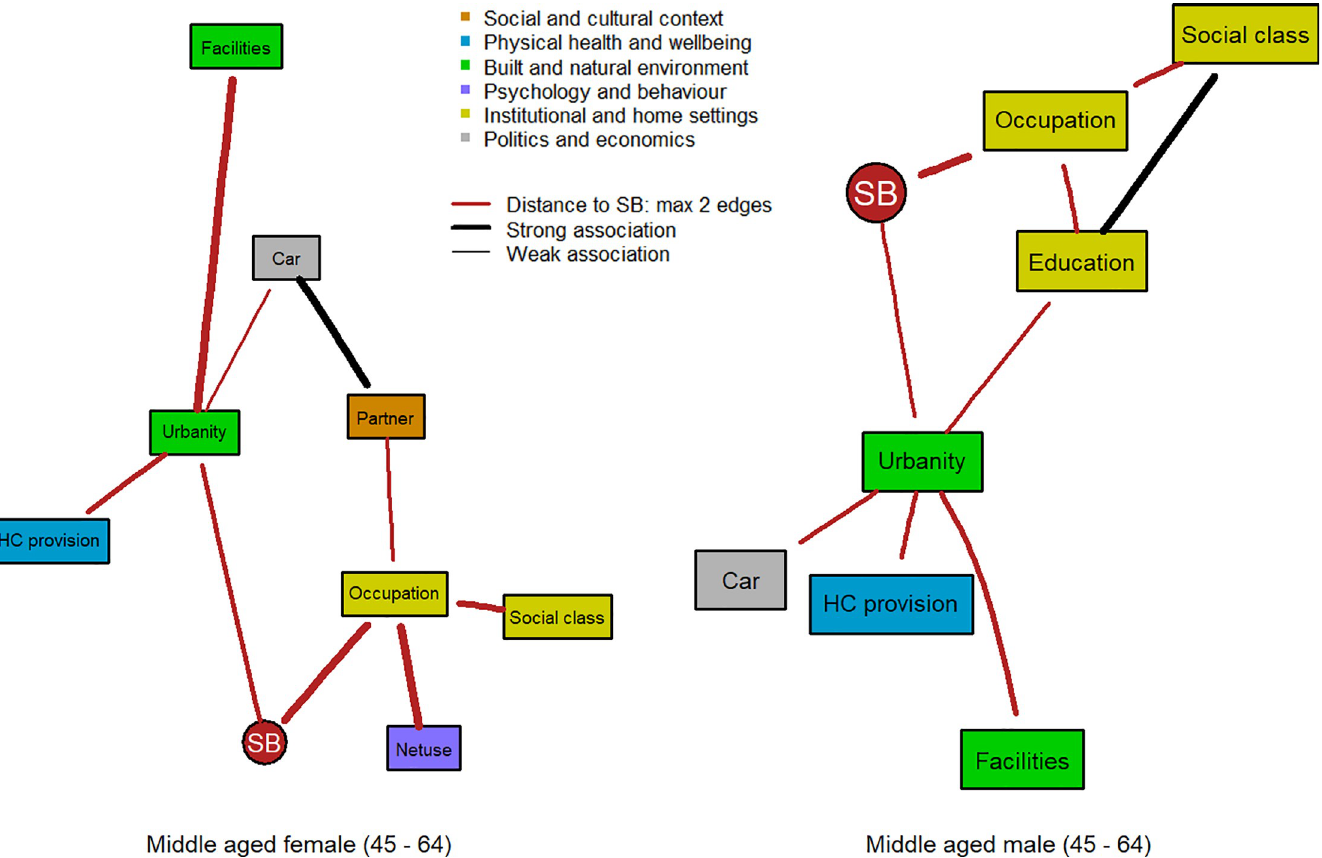
Fig 4. Factors linked to SB within two edges distance in the subgraphs for middle-aged females (4a: left; N = 4,797) and middle-aged males (4b: right; N = 3,907).